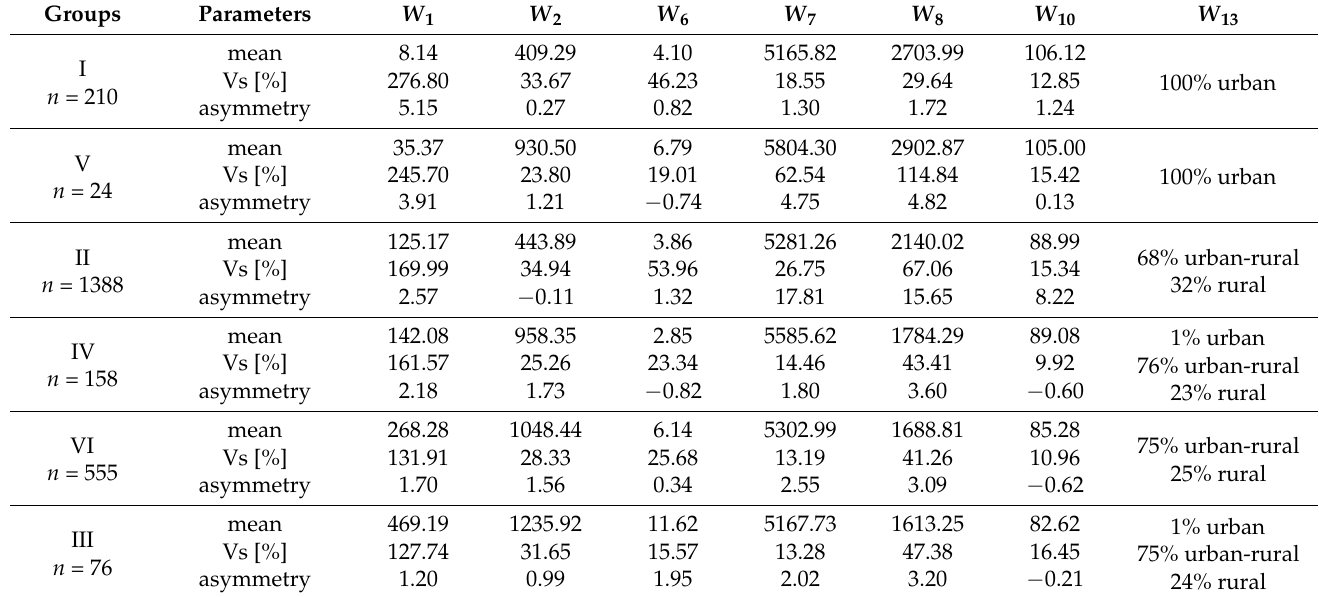
Table 4. Parameters of the distribution of the values of indicators in the groups of communes ordered in ascending order according to the average values of the indicator W 1 .